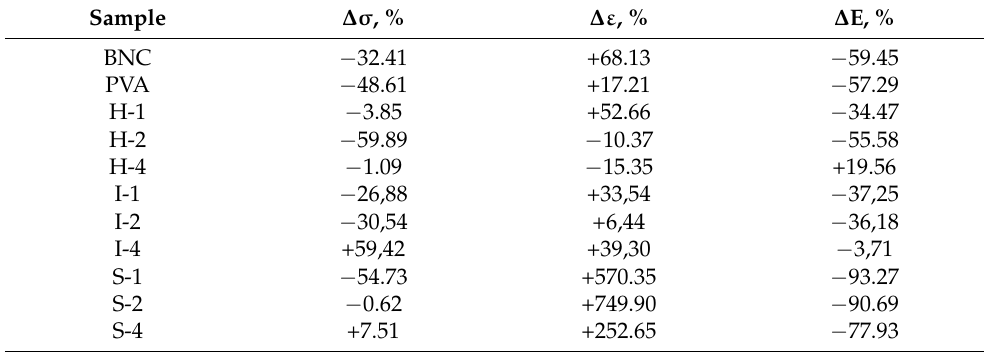
Table 4. Changes in strength parameters (%) caused in BNC and PVA samples and BNC/PVA blends after 4 h UV